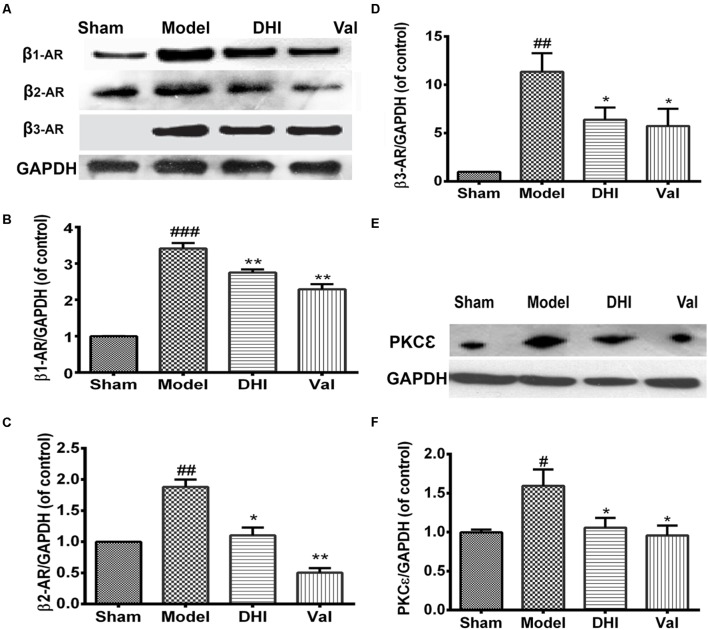
Similar and differential effects of DHI on β-AR subfamily member expression and downstream signaling proteins in MI model. (A,E) Are representative western blot bands of β-ARs and PKCε respectively in different groups. (B–D,F) Semi-quantitative analysis of heart’s β1-, β2-, and β3-AR, and PKCε in various groups. The over-expression of β1-AR, β2-AR, and β3-AR locally in the heart in the model group (##p < 0.01, ###p < 0.001 vs. sham) were significantly inhibited by DHI (∗∗p < 0.01 and ∗p < 0.05 vs. model; A–D). Also, PKCε over-expression in the heart (#p < 0.05 vs. sham), was significantly decreased by valsartan and DHI (E,F), n = 3 in each group, data are presented as mean ± SEM.